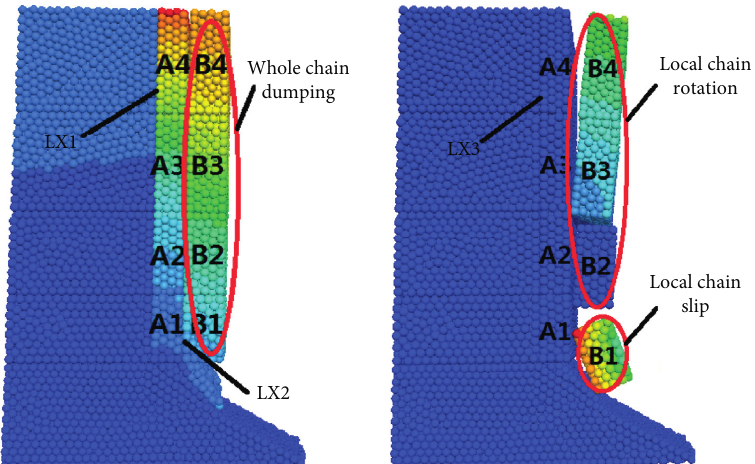
Figure 4: Failure modes of Model 1 and Model 2 slope after 25s of seismic